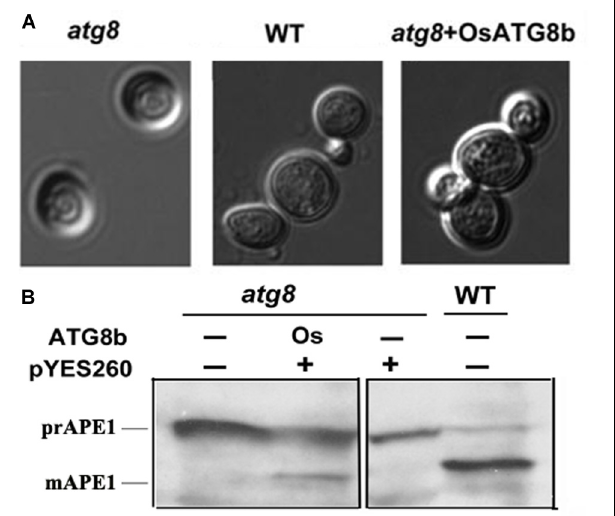
FIGURE 1 | Functional complementation of yeast atg8 mutant by OsATG8b . OsATG8b cDNA was cloned into the plasmid pYES260 and expressed in yeast atg8 mutant KVY5 strain. (A) OsATG8b restores normal cell morphology of the yeast scatg8 mutant under N starvation. Abnormal morphology of scatg8 yeast cell (left), compared with normal cell of wild-type (WT) yeast (middle), and scatg8 yeast transformed with OsATG8b (right). (B) API protein identification by Western blot. Yeast cells were grown to mid-log phase to be collected and washed, incubated in the presence of 2% galactose to induce OsATG8b expression, and then incubated for another 5 h in nutrient deprivation medium and harvested for protein extraction. Proteins were